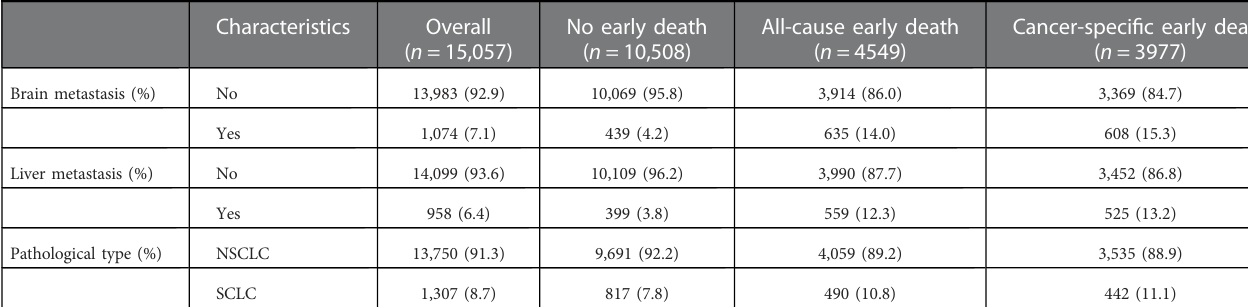
TABLE 2 The baseline characteristics of the training and validation cohorts.